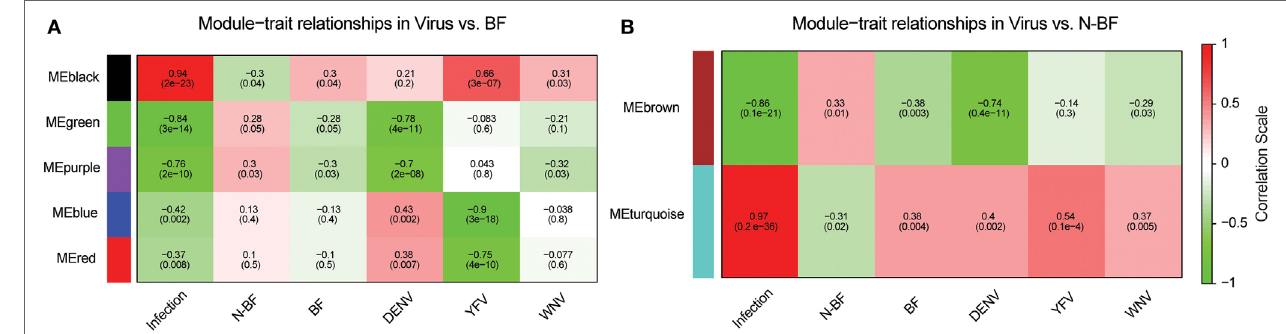
FigUre 4 | Identification of coexpression modules in infected vs. blood-fed (BF) and infected vs. nonblood-fed (N-BF) comparison. Pearson’s correlation of module eigengenes with traits (infection by each virus, BF, N-BF) are presented for each module (labeled black , green , purple , blue, red, brown , and turquoise ) and corresponding p -value of the correlation in cells colored by the strength of the correlation. (a) Comparison of differentially expressed genes (DEGs) of infected vs. BF mosquitoes. (B) DEGs of infected vs. N-BF